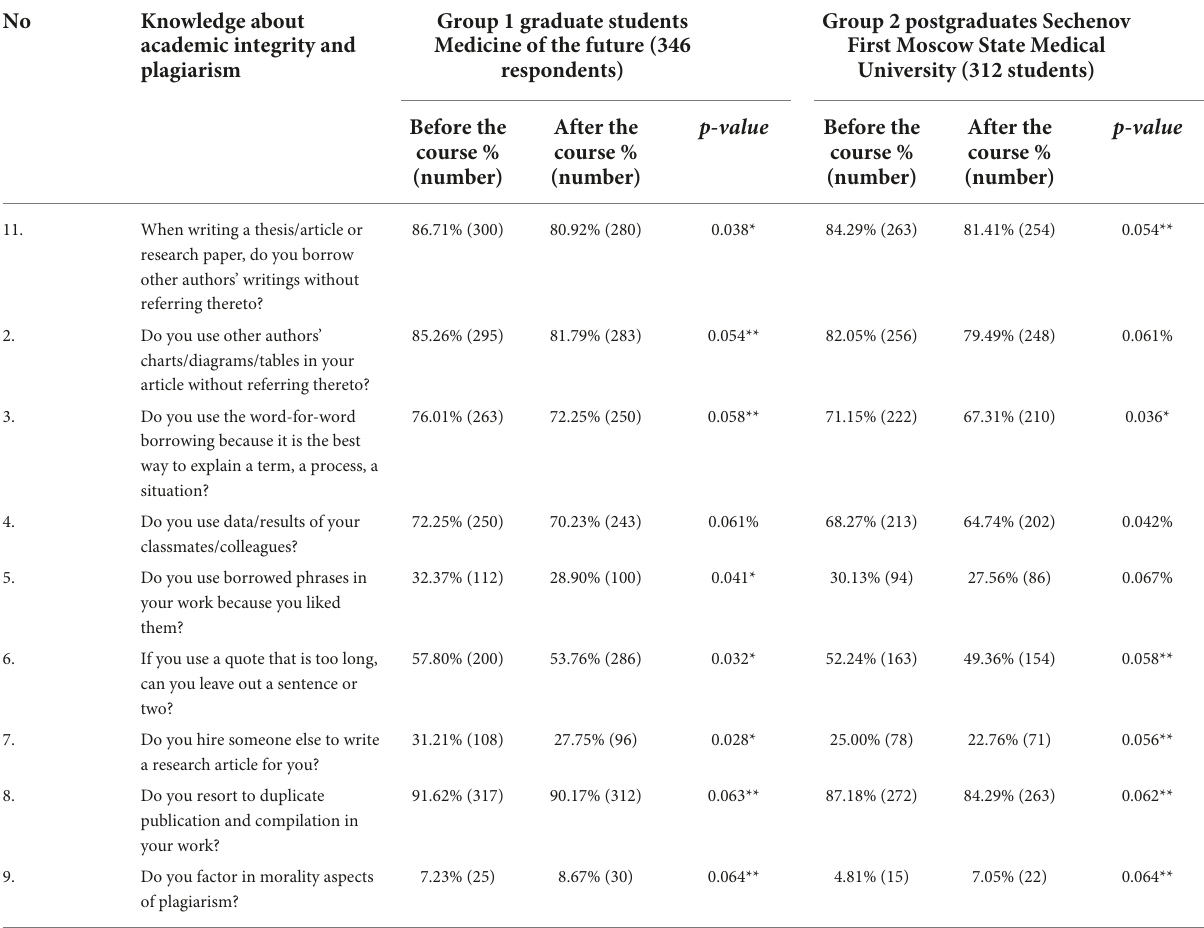
TABLE 2 Level of knowledge about academic integrity and plagiarism among medical